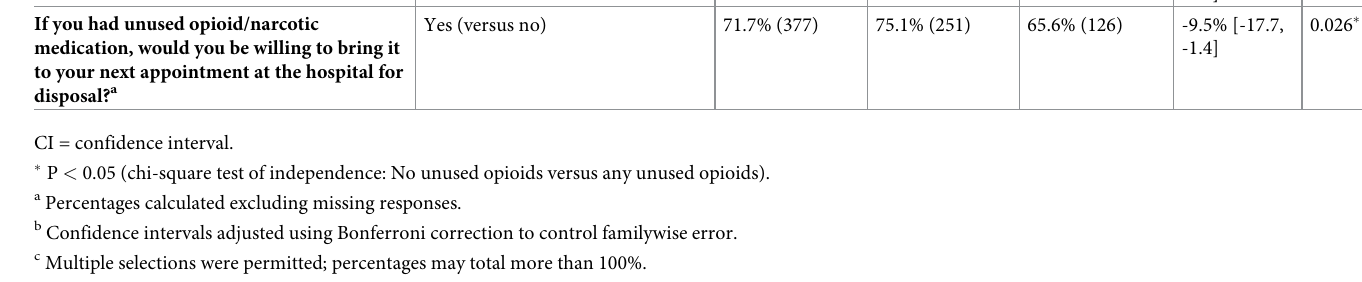
Table 3. Reasons for not wanting to participate in an opioid take-back program, overall and by presence of unused opioids at home.